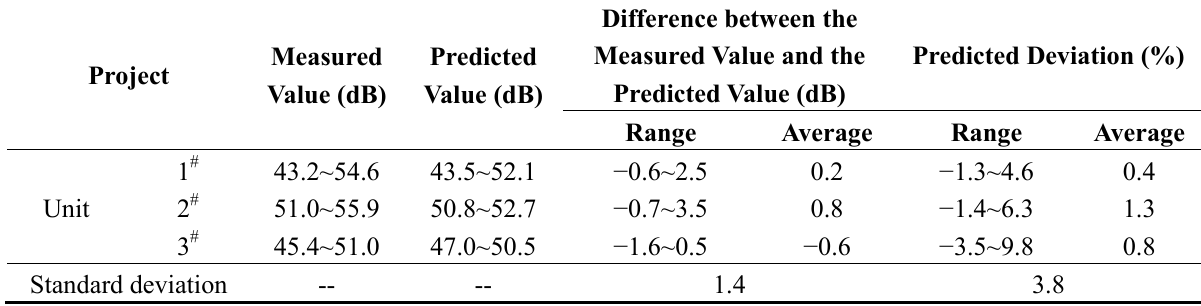
Predicted Deviation (%)